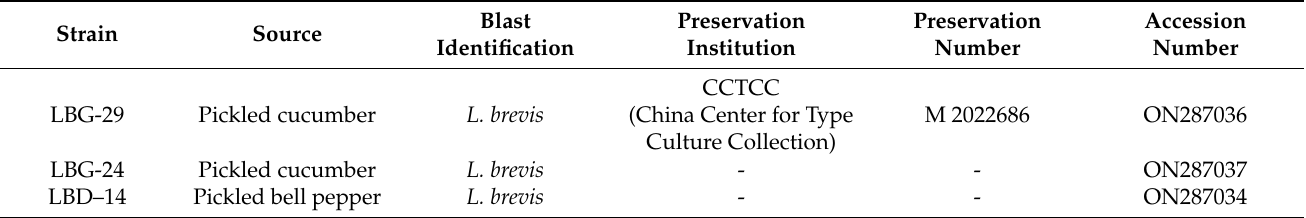
Table 1. Isolate